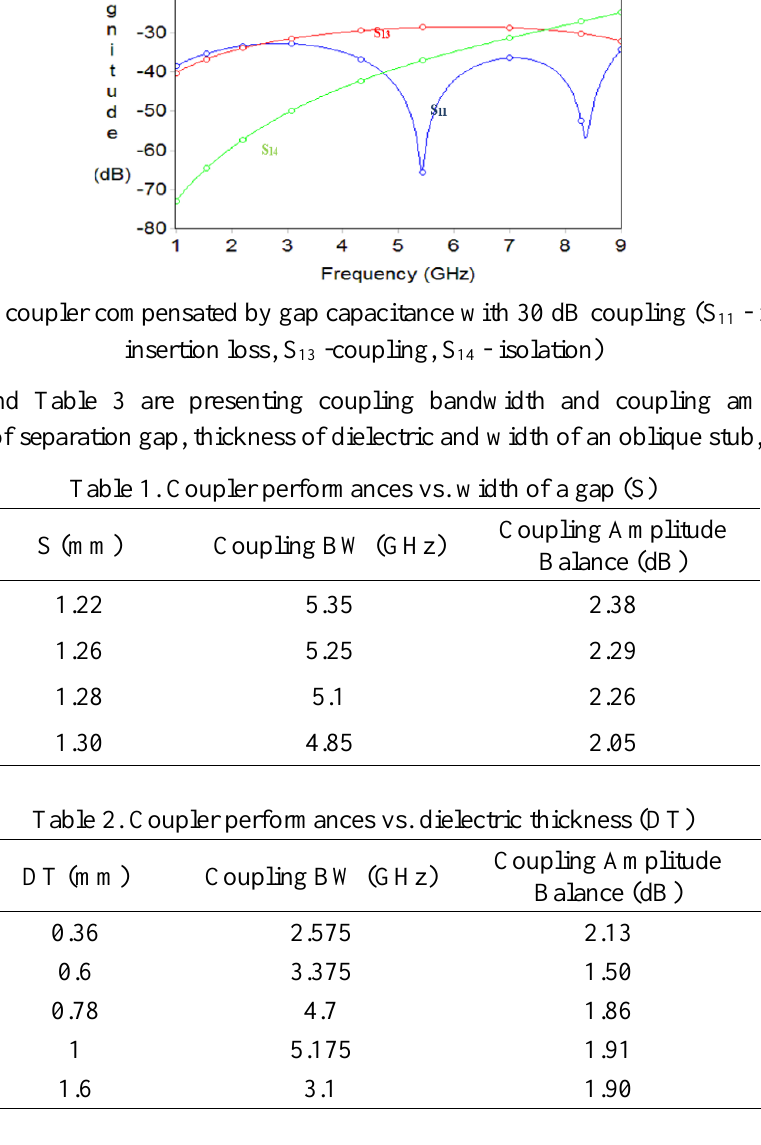
Figure 6. Microstrip coupler compensated by gap capacitance with 30 dB coupling (S